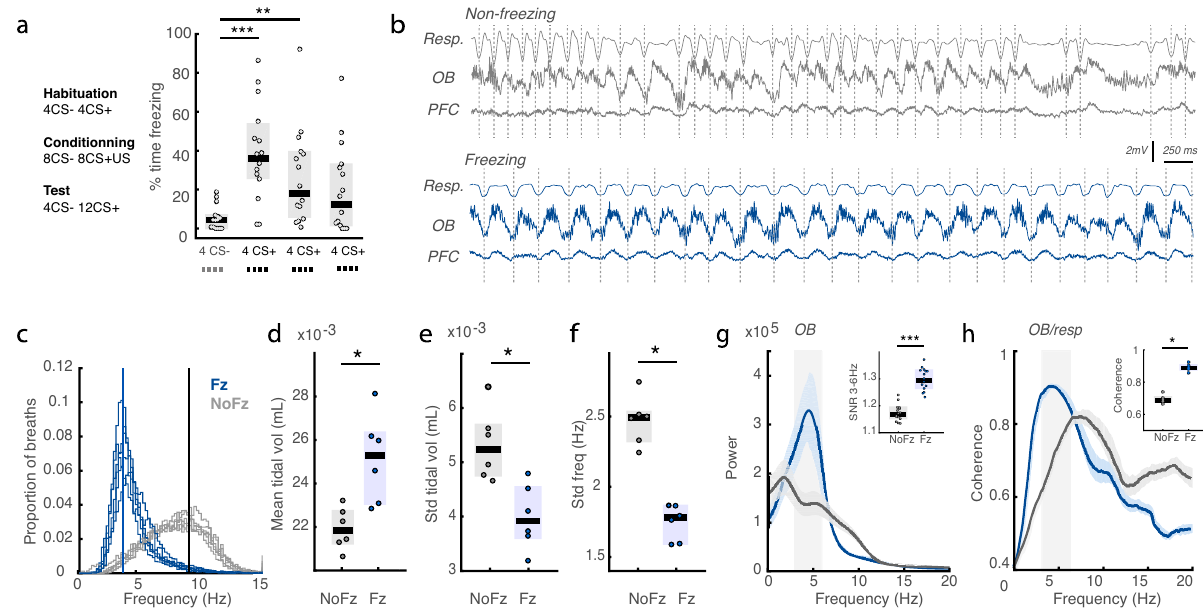
Fig. 1 During freezing, regular 4 Hz breathing entrains the olfactory bulb. a Experimental protocol and behavioural results: median percentage of time spent freezing for all mice during the CS − and CS + , grouped as blocks of four sounds (4CS − followed by 12 CS + ). Sound block signi fi cantly affected freezing rates (Friedman test: X 2 (3) = 19.6, p = 2.01e − 4). Post-hoc analysis revealed signi fi cant differences of the CS + blocks compared to the CS − block (Wilcoxon signed-rank test: Signed Rank statistic = 0,14,23; p = 6e − 5, 0.0067, 0.0353, n = 15). b Illustrative example of breathing activity as recorded in the plethysmograph and OB and dmPFC LFPs during exploratory and freezing periods. Note the striking regularity and synchronicity in the 3 – 6 Hz range in all three time courses during freezing. c Distribution of breathing frequencies recorded in the plethysmograph during freezing and non-freezing periods. ( n =